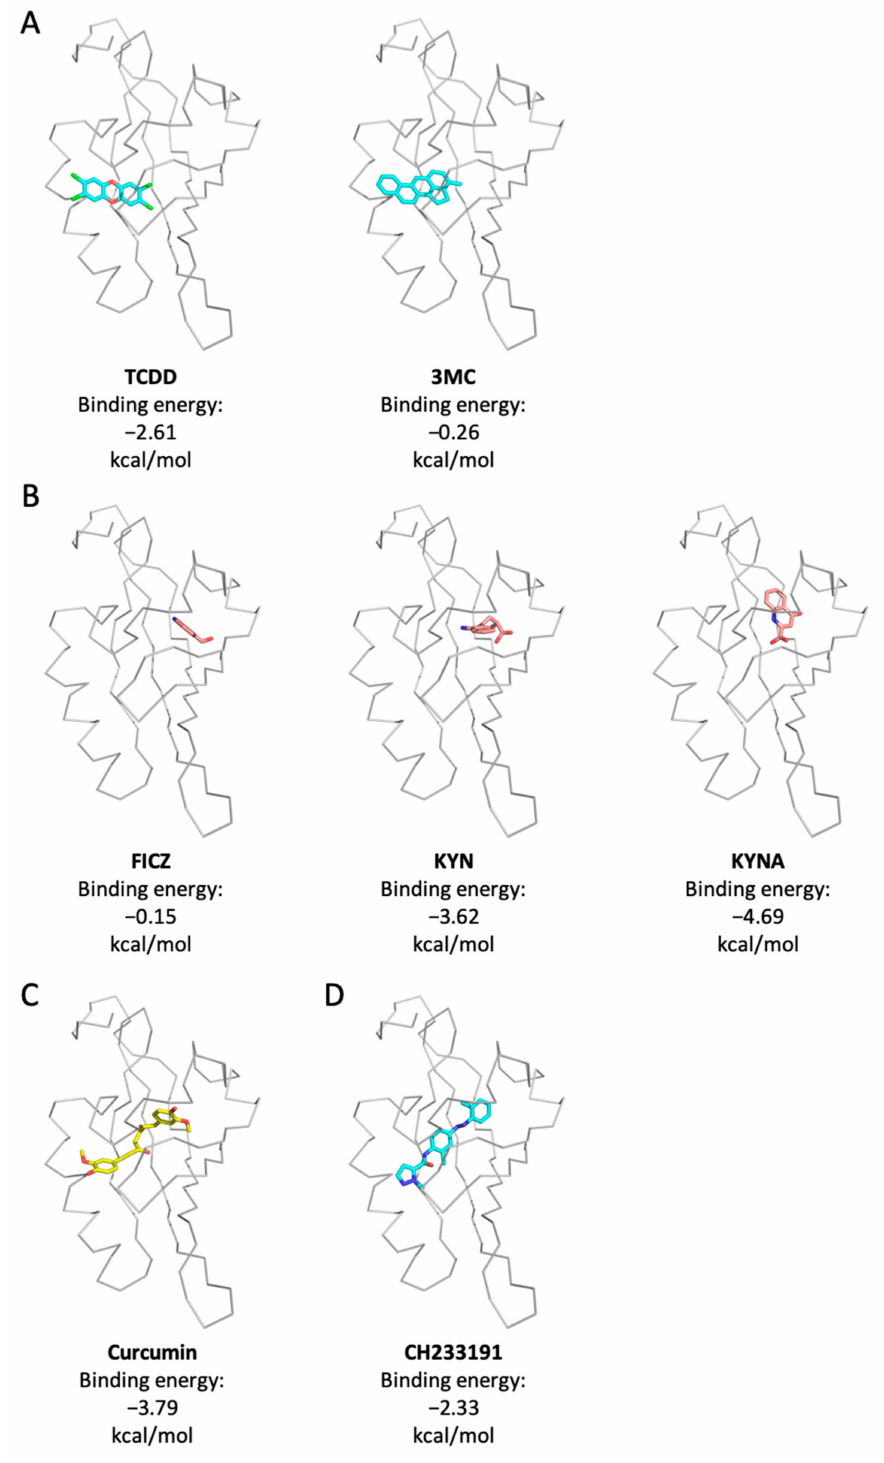
Figure 5. Molecular docking modeling of curcumin and classic AhR ligands with AhR. Binding pockets predicted for AhR PAS-B domain. Binding models of TCDD and 3MC ( A ), FICZ, kynurenic acid (KYNA), and kynurenine (KYN) ( B ), curcumin ( C ), and CH233191 ( D ) in the context of human AhR are shown. Note that TCDD and 3MC bound on the classic binding site of AhR, while FICZ, KYN, and KYNA bound on a newfound ligand binding site of AhR. Curcumin bound to the classical binding site. AhR, Aryl hydrocarbon receptor; TCDD, Tetrachlorodibenzo-p-dioxin; IDO, Indoleamine 2,3-dioxygenase; FICZ, 6-Formylindolo[3,2-b]